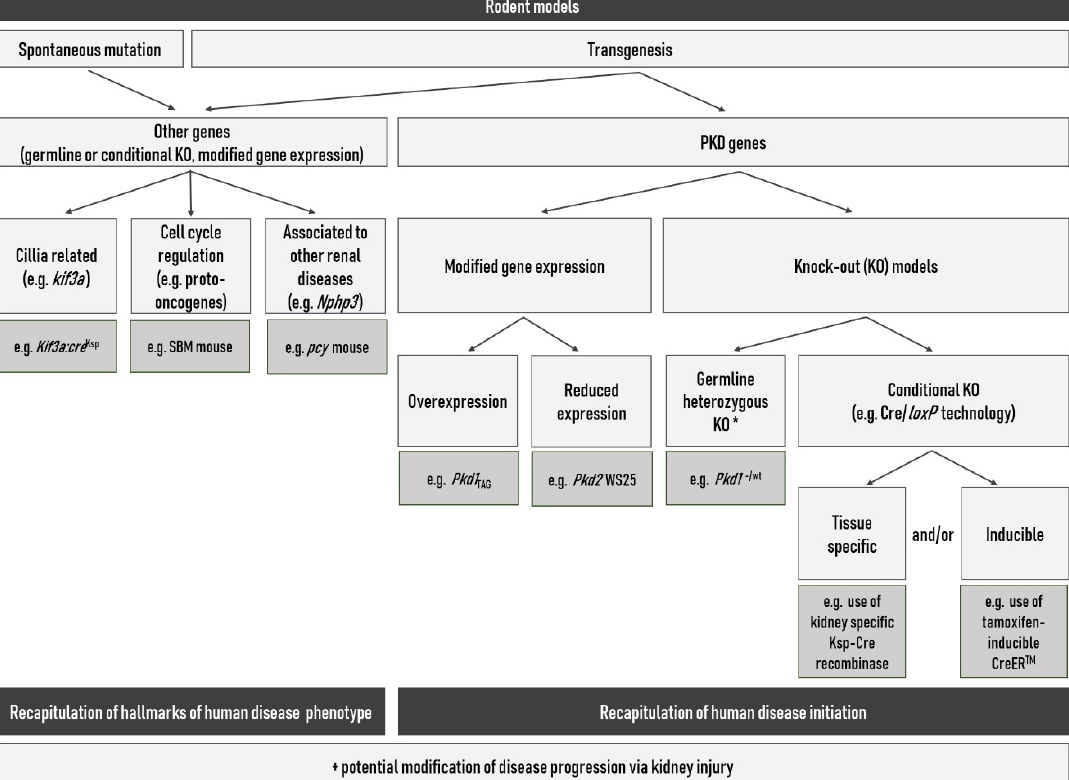
Figure 3. Schematic overview of the different types of rodent ADPKD models (adapted from [28]). *: homozygous germline knock-out embryonically lethal